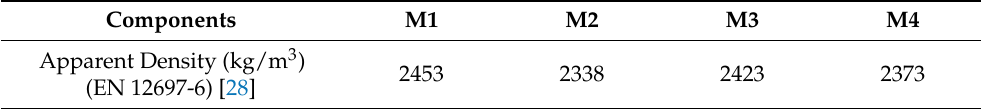
Table 5. Density of the asphalt mortars